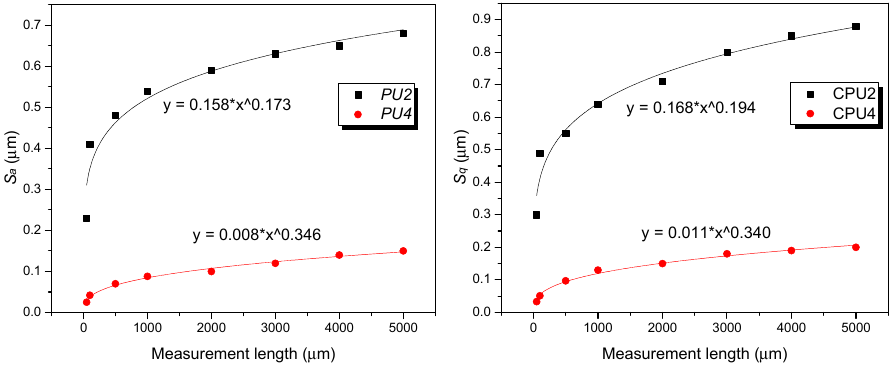
Figure6. Surfaceroughness S a and S q asafunctionofmeasurementlengthfor PU2 and PU4 Figure 6. Surface roughness S a and S q as a function of measurement length for PU2 and PU4 , respectively.